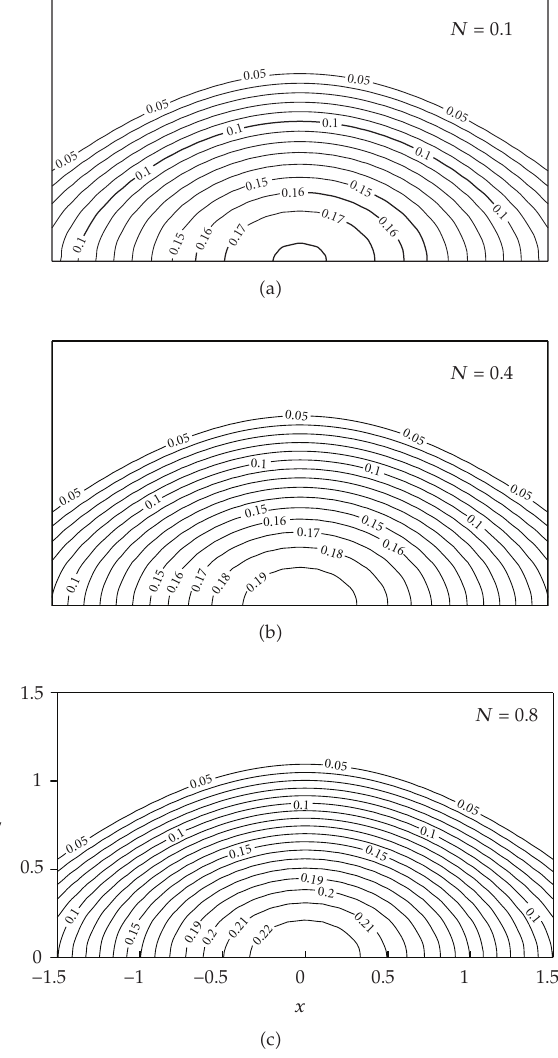
Figure 17: Magnetic-force lines for di ff erent values of N